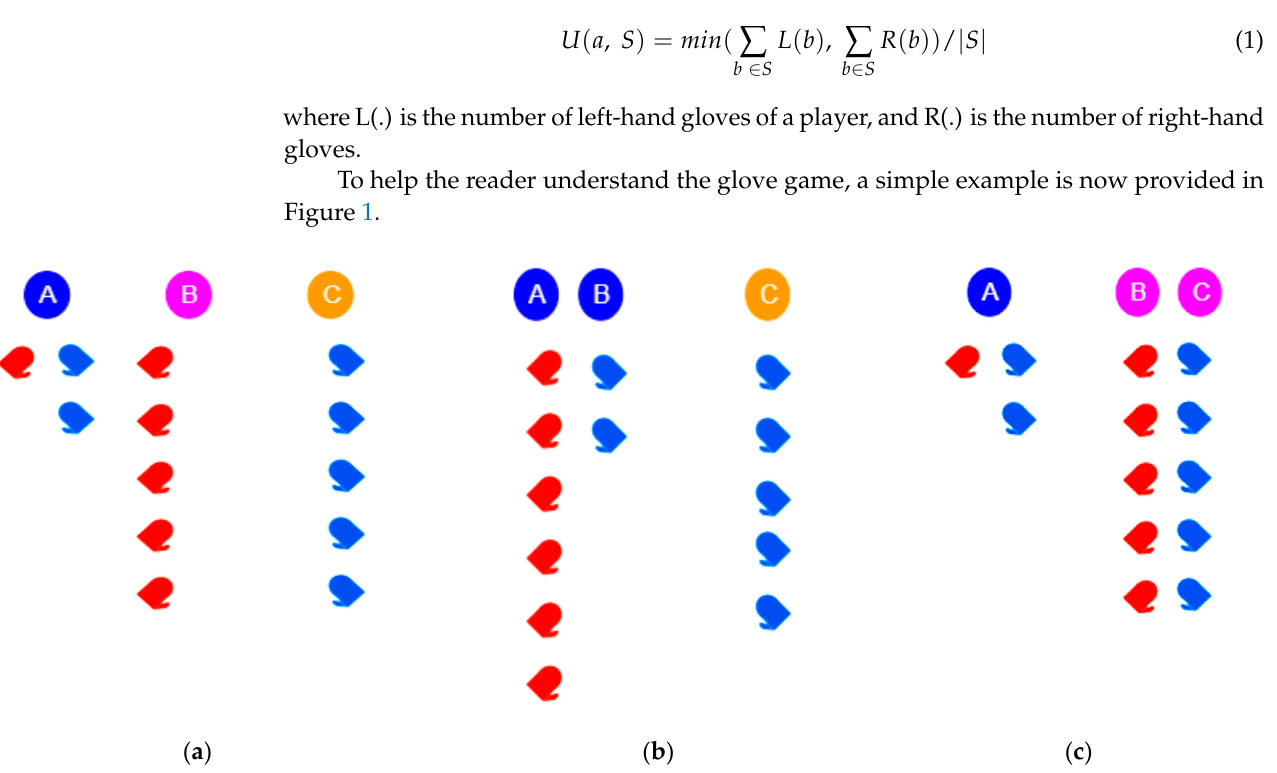
Figure 1. A simple example of glove games: ( a ) Initial game structure; ( b ) An unstable coalition structure; ( c ) The stable coalition structure.